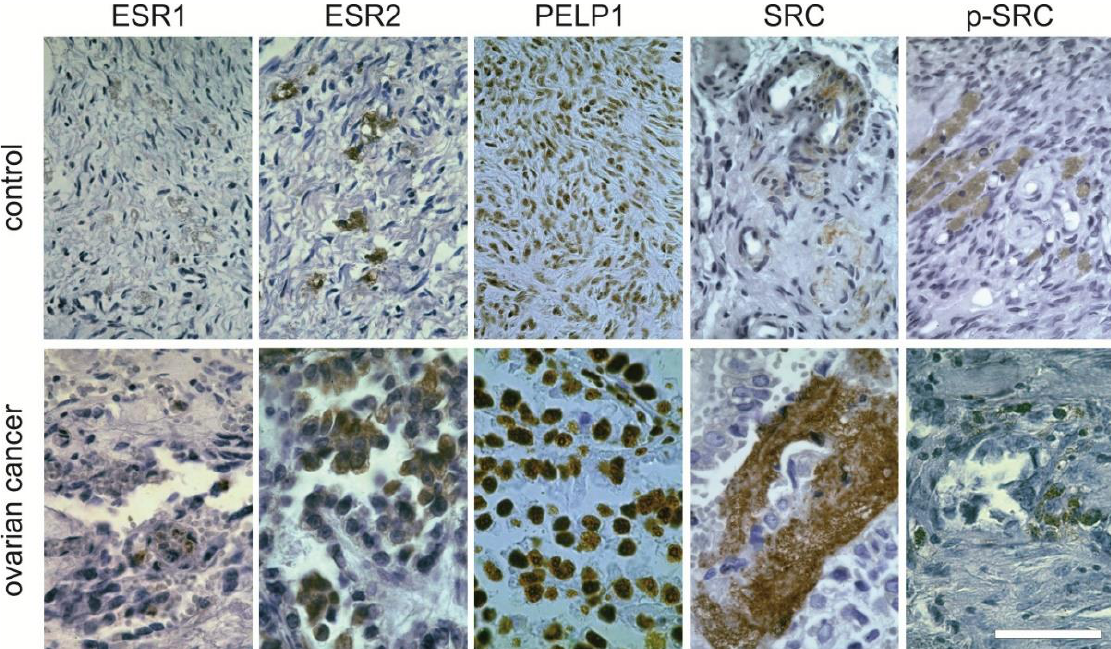
Figure 6. Immunohistochemical staining for analyzed proteins in controls and ovarian cancer tissue. Positive staining is shown in brown. The bar represents 100 µm. This section may be divided by subheadings. It should provide a concise and precise description of the experimental results, their interpretation, as well as the experimental conclusions that can be drawn.